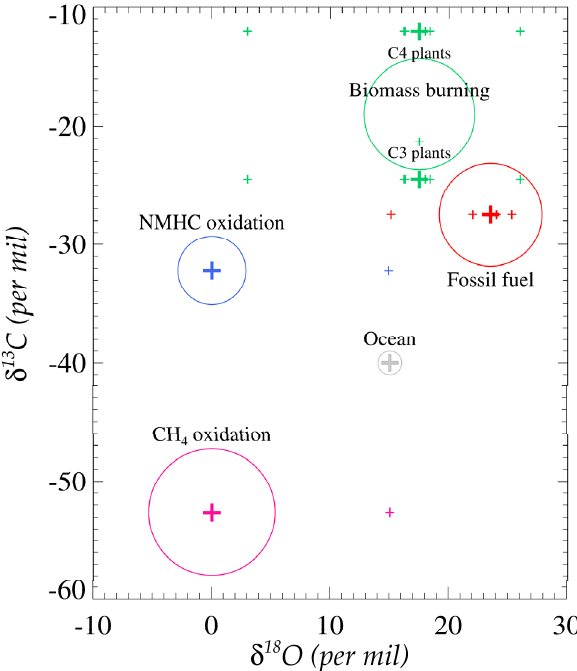
Figure 2. Isotopic source signatures of CO based on data in Table S2. The size of each circle represents the relative source strengths estimated in IPCC 2001